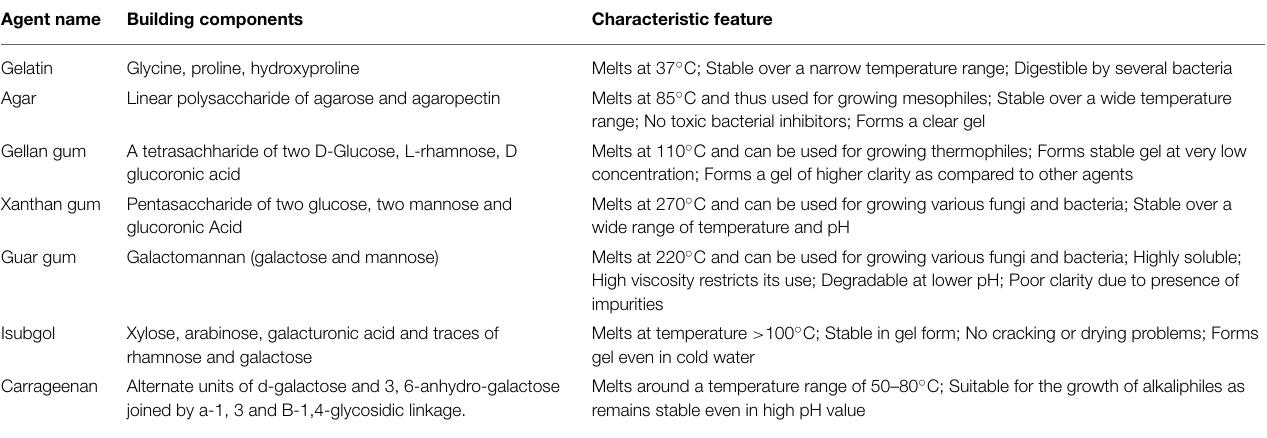
TABLE 1 | Properties of various gelling